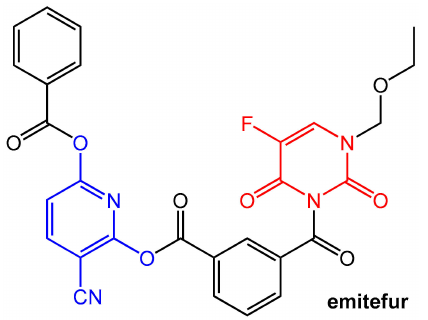
Figure 19. Emitefur (BOF-A2) is a mutual pro-drug in which a 5-FU (marked in red) derivative is covalently coupled (using an inert isophthalic acid unit) with a CNDP (marked in blue)